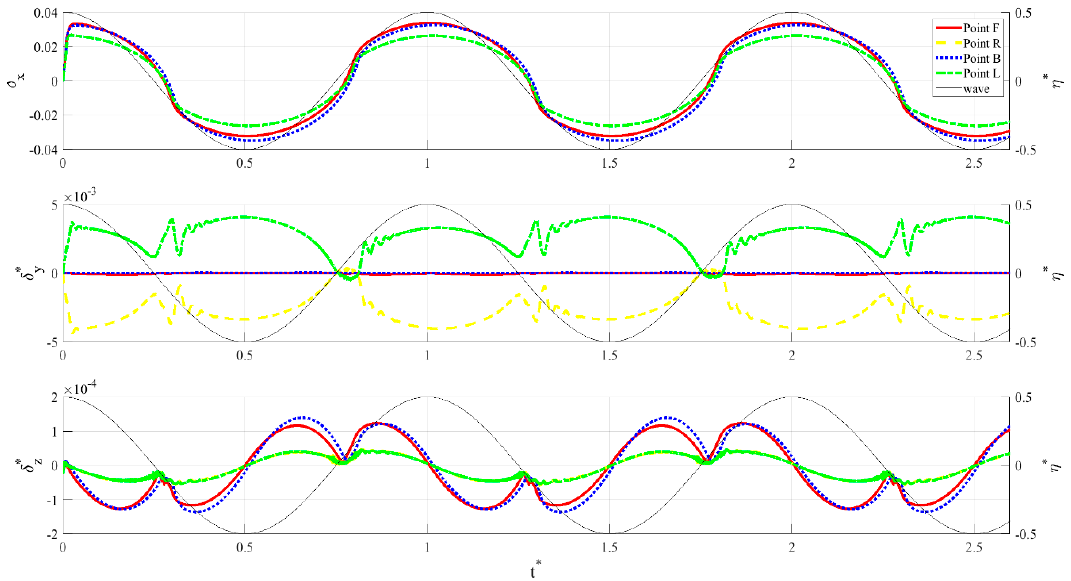
Figure 4. Displacements of the four significant mid-height nodes in the wave direction (top panel), cross-flow direction (middle panel) and vertical direction (bottom panel), for the linear wave test. The black dashed line represents the water elevation above the front of the cage η * = η /H . Table 1. Maximum and minimum displacements in each direction of the reference points, with the